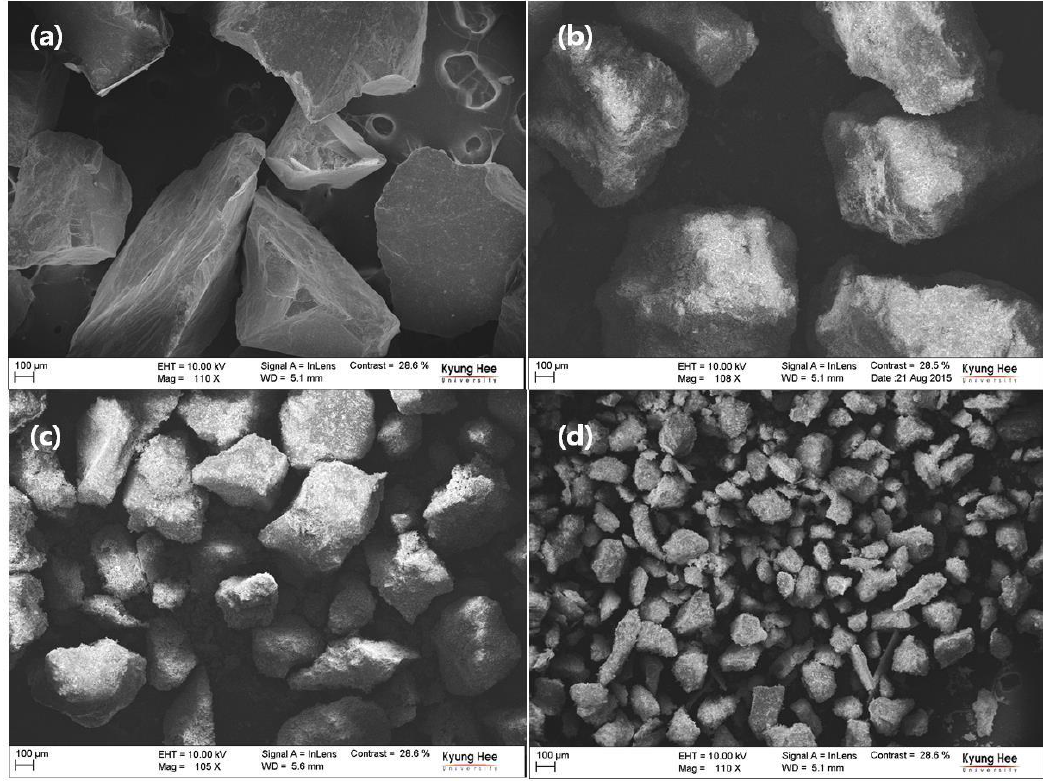
Figure 6. SEM images of the four types of soil samples before the cleaning process (four-year-old samples). ( a ) Sea sand; ( b ) coarse soil sand; ( c ) medium soil sand; ( d ) fine soil sand.